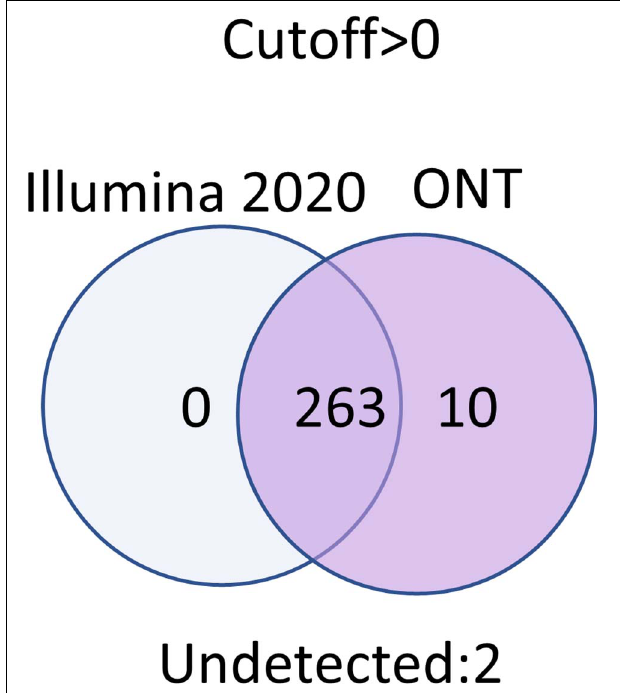
FIGURE 5 | Results obtained using the Illumina and ONT technologies at a cutoff level >